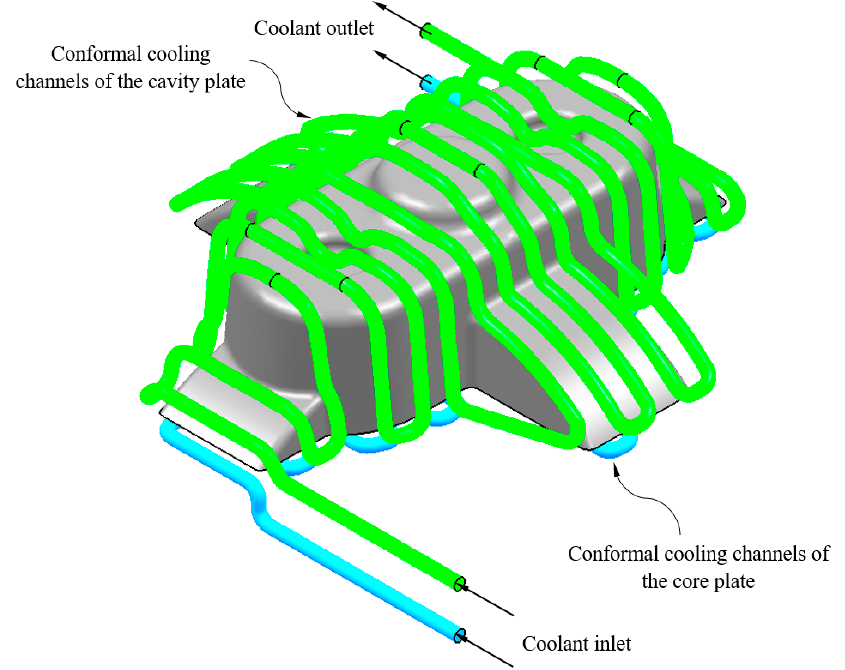
Figure 12. Three-dimensional Computer Aided Design modeling of conformal type cooling channels.